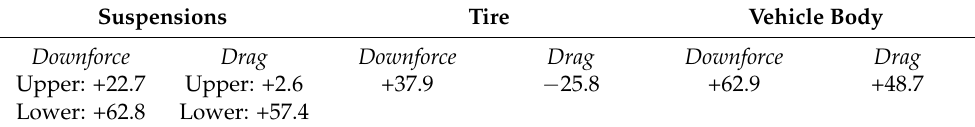
Lower: +62.8 Lower: +57.4